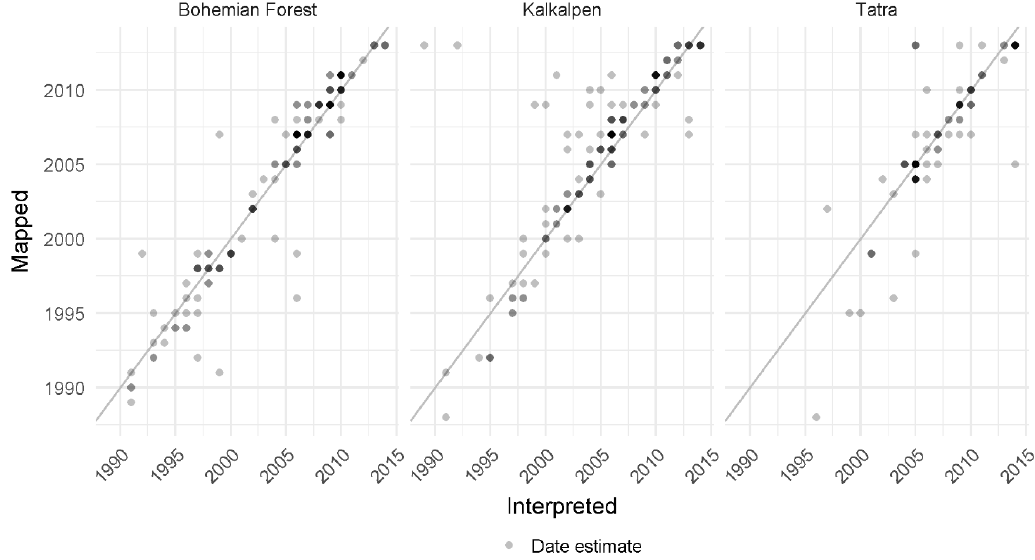
Figure 4. Scatterplots of disturbance year estimates obtained from visual interpretation (interpreted) and disturbance years obtained from the breakpoint detection algorithm (mapped). Diagonal lines represent complete agreement. Data points are plotted with 75% transparency.